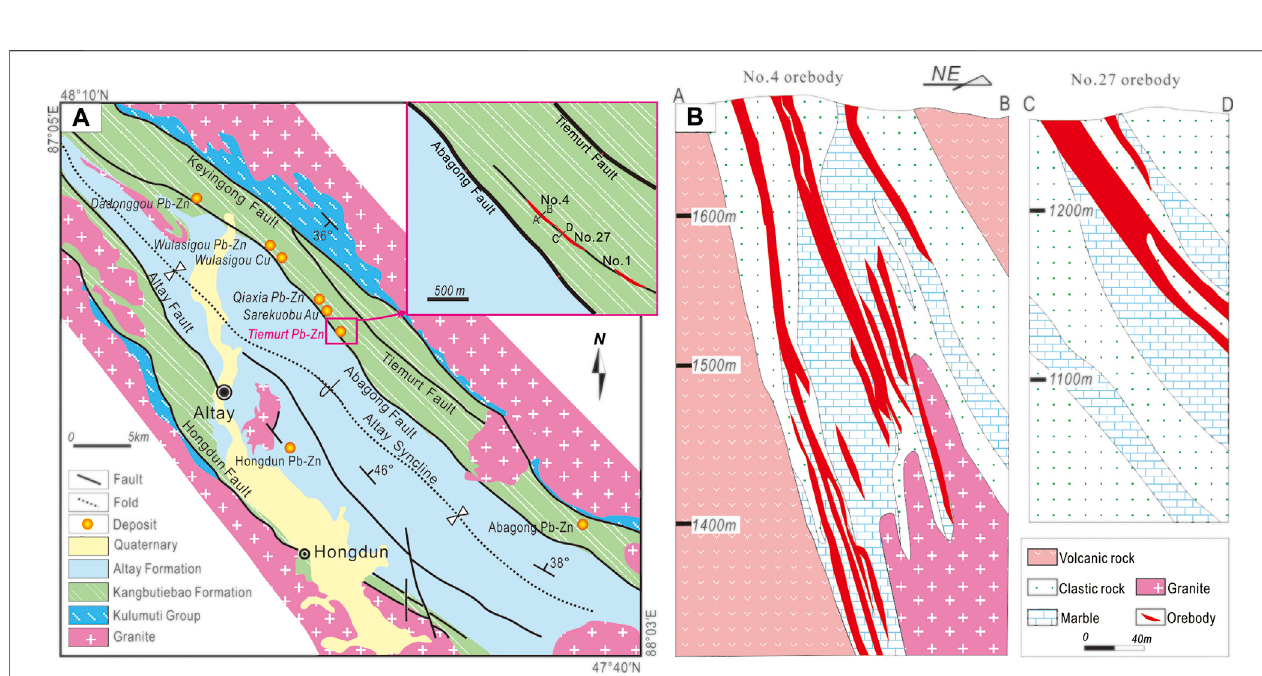
FIGURE 1 | (A) Tectonic framework of the Central Asian Orogenic Belt. (B) Geological sketch map showing the tectonic units of North Xinjiang (Chen et al., 2012). Siberiaplate:S1,LateDevonian – EarlyCarboniferousNurtvolcanicbasin;S2,PaleozoicKeketuohaimagmaticarc;S3,Devonian – CarboniferousKelanforearcbasin;S4, Armantay-Irtysh accretionary wedge. Kazakhstan plate; K1a, Zharma-Sawur island arc; K1b, Western Junggar accretionary complex; K1c, Eastern Junggar accretionary complex; K1d, Mesozoic – Cenozoic Junggar basin; K1e, Late Paleozoic Yelianhabirga backarc basin; K1f, Late Paleozoic Bogada aulacogen; K1g, Paleozoic Harlike island arc; K1h, Dananhu island arc; K1i, Mesozoic – CenozoicTurpan basin; K2a, Sailimu massif; K2b, Wenquan terrane; K2c, Paleozoic Boloholoarc basin system; K2d, Paleozoic Yamansu-Jueluotag arc basin system; K2e, Carboniferous – Permian Ili rift; K2f, Early Paleozoic central Tianshan island arc with Precambrian fragments; K2g, Nalati massif. Tarim Plate: T1, Mesozoic – Cenozoic Tarim basin; T2a, Precambrian Kuruktag massif; T2b, Muzart massif; T3a, Carboniferous – Permian Beishan aulacogen; T3b, Late Paleozoic Kalatierek passive marginal sediments; T4a, Late Paleozoic Southwest Tianshan fold-thrust belt; T4b, Paleozoic Southern Tianshan (or Kumishi) accretionary complex.